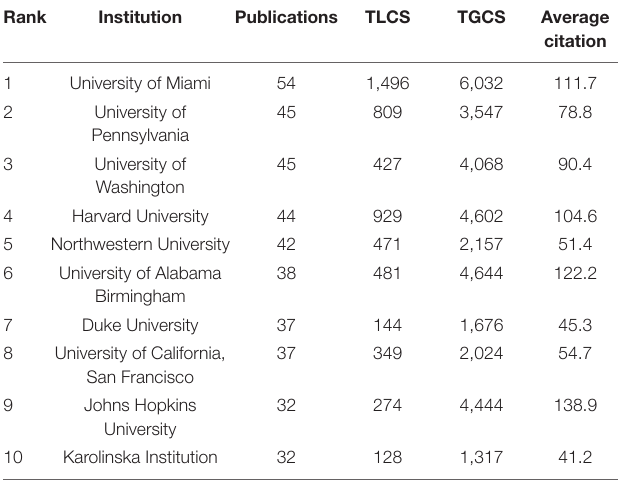
TABLE 2 | The top 10 productive institutions concerning uremic